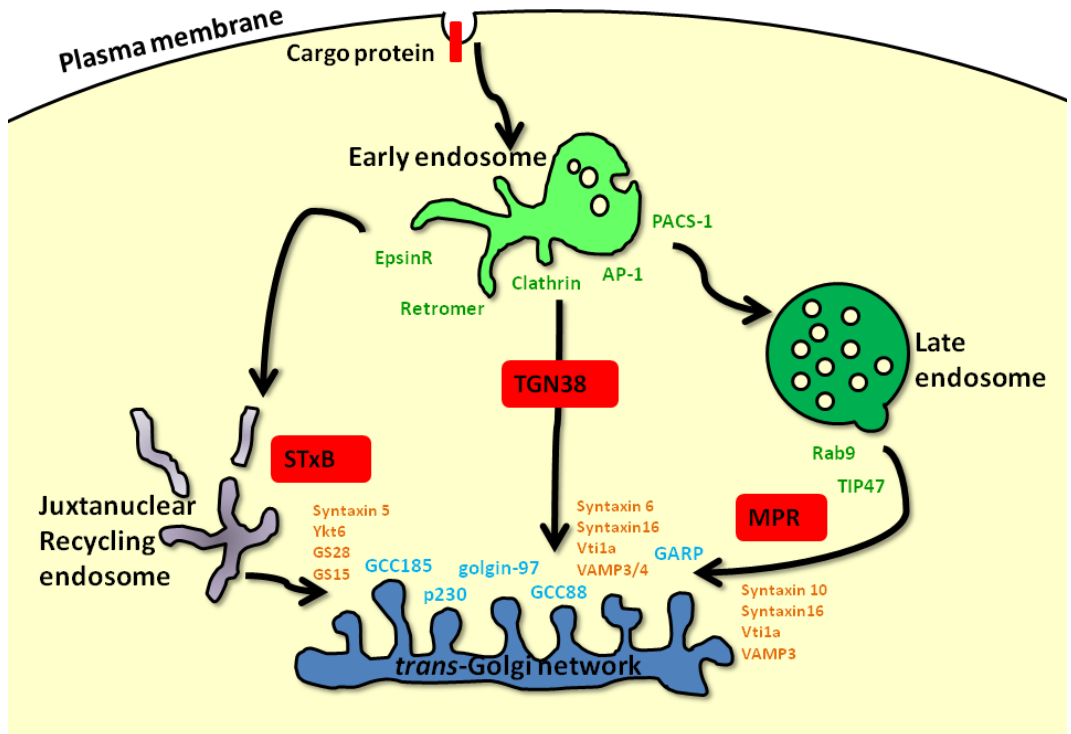
Figure 1. Machinery and cargoes along retrograde transport pathways.After internalization from the plasma membrane (PM) to the early endosome, protein cargoes (red rectangle) can undergo retrograde transport back to the TGN via a number of endosomal compartments. Shiga toxin B (STxB) and TGN38 utilize the early/recycling endosome-to-TGN route, whereas mannose 6-phosphate receptors (MPRs) use the late endosome-to-TGN pathway. Retrograde transport from the various endosomal compartments is mediated by different sets of machinery. The adaptor proteins, AP-1 and epsinR, aid in the recruitment of the clathrin and retromer coats to the early endosome, whereas late endosome-derived vesicles are characterized by the non-clathrin coat protein, TIP47. The processes of tethering, docking and fusion of transport intermediates with the trans -Golgi network (TGN) are mediated by distinct sets of machinery. Members of the TGN golgin family, p230, golgin-97, GCC88 and GCC185, and the multisubunit tethering complex, GARP, function as tethers (blue text). Distinct SNARE complexes mediate fusion events of different transport intermediates with the TGN (orange text). Reviewed in Bonifacino and Rojas, 2006, and Johannes and Popoff,